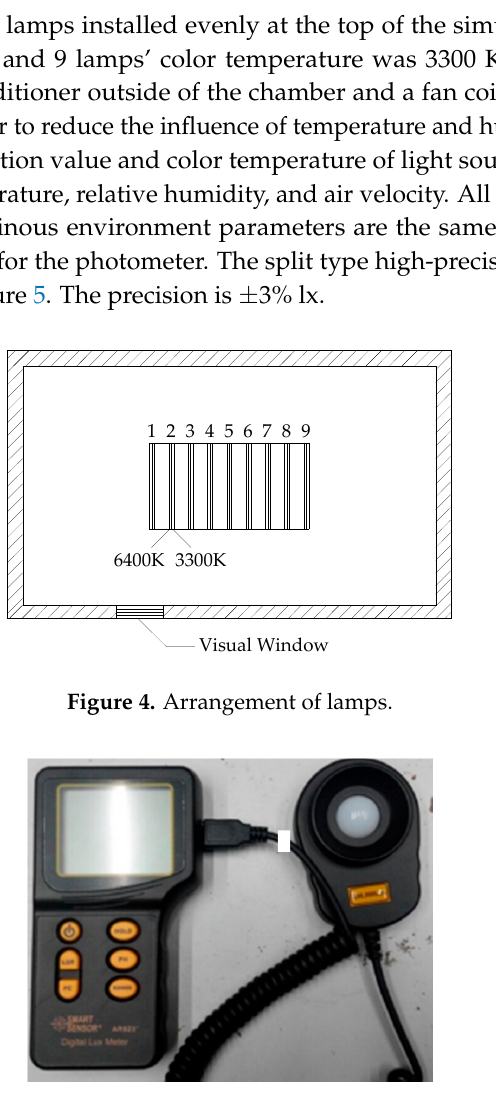
Figure 5. Photometer.